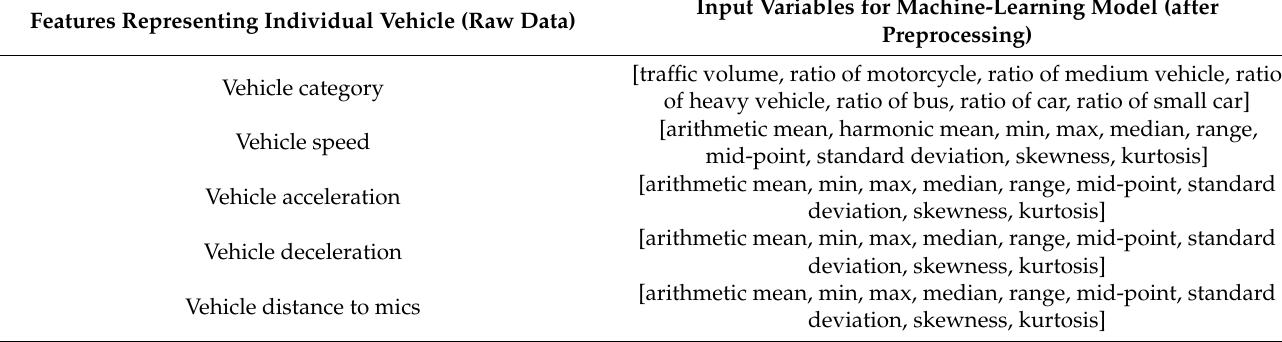
Table 4. The input variables of the machine-learning